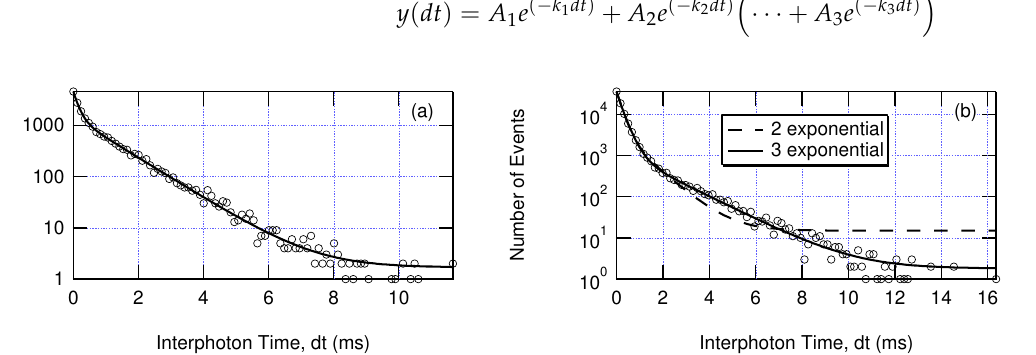
Figure 2. Multi-exponential fitting to histograms of interphoton times using Equation (1). ( a ) A photon trajectory well-fit by two exponential terms (background and fluorescent emitting states). ( b ) A photon trajectory better-fit by three exponential terms (background and two fluorescent emit- ting